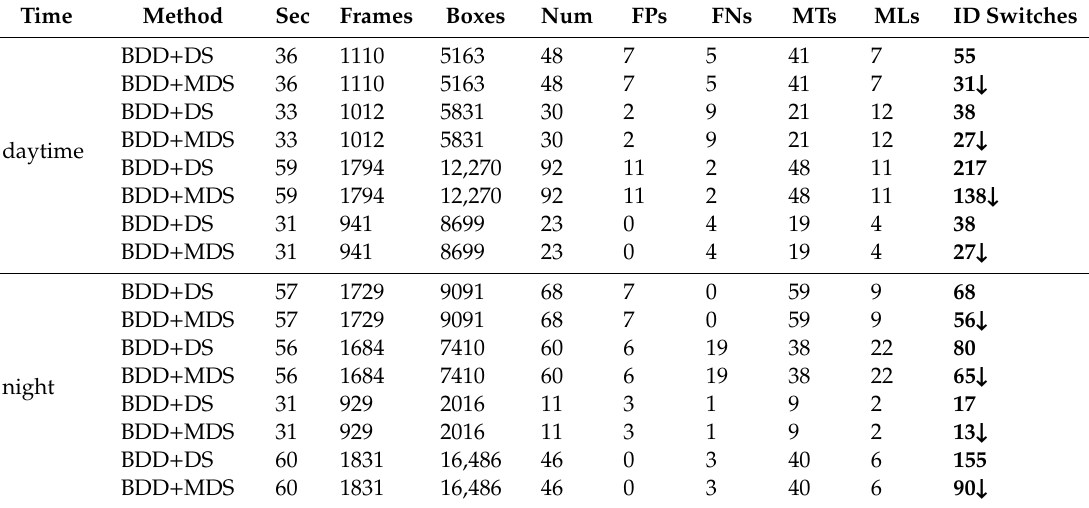
Table 2. Samples of vehicle tracking using the MDS (Modified Deep SORT) and DS (Deep SORT) algorithms with a detection model trained on the BDD100K dataset.